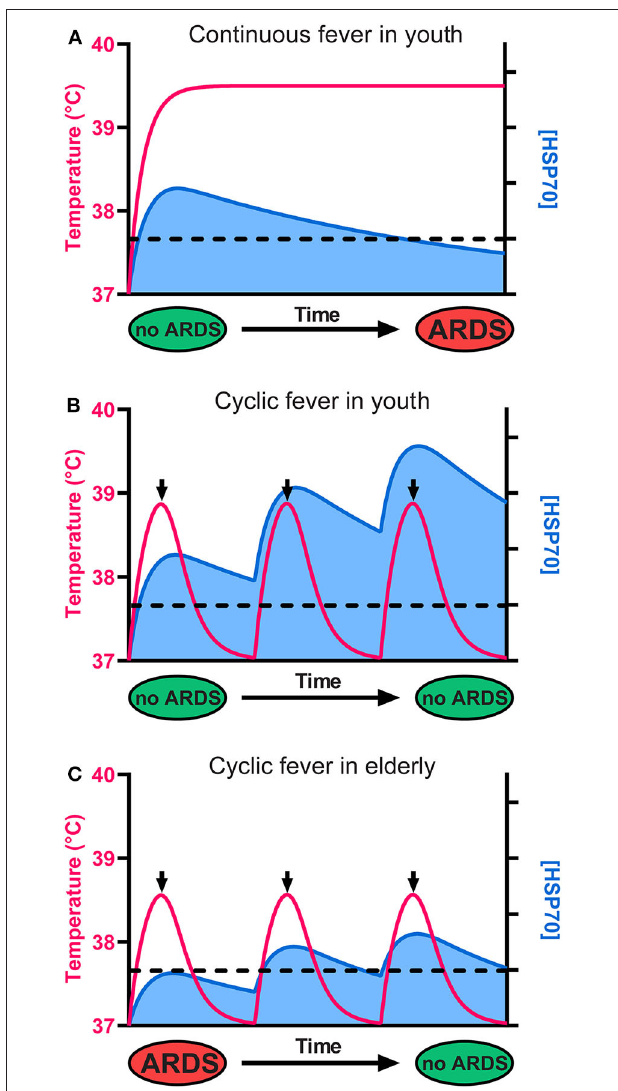
FIGURE 2 | The cellular levels of HSP70s determine the fate of alveolar cells, leading to survival or to ARDS and death. (A) Although it initially protects cells from ARDS, a continuous high fever in the long term leads to HSP70 depletion, ARDS, and death. (B) In youth, a cyclic mild fever up to 38.8 ◦ C (red line) causes in the first hours a strong beneficial accumulation of HSP70s (blue) that can potentially arrest sepsis-induced ARDS in young COVID-19 patients. Because long-term continuous fever leads to HSP70 depletion, the use of antipyretics after 2h of fever is recommended. Iterative cycles of mild fever can thus maintain and even accumulate high cellular levels of protective HSP70s above a critical threshold (dashed line), preventing ARDS. (C) In seniors, the baseline temperature is often lower than 37 ◦ C, fever is often less intense, and less protective HSP70s accumulate. However, iterative fever cycles can accumulate protective HSP70s above the critical threshold (dashed line), arresting ARDS even in seniors.